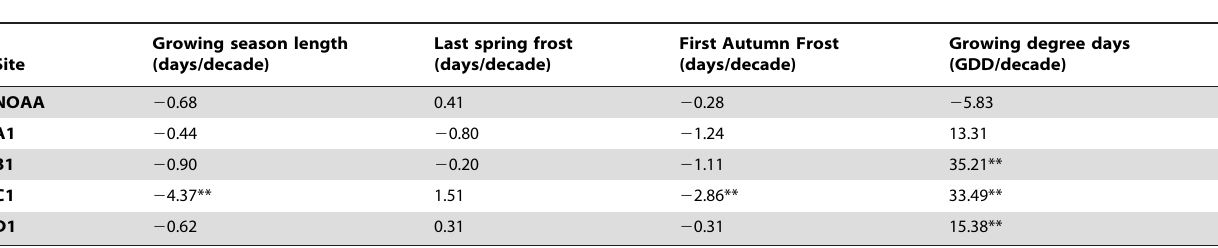
Table 5. Fifty-six-year trends (1953–2008) in growing season length, first autumn frost, last spring frost, and growing degree days.